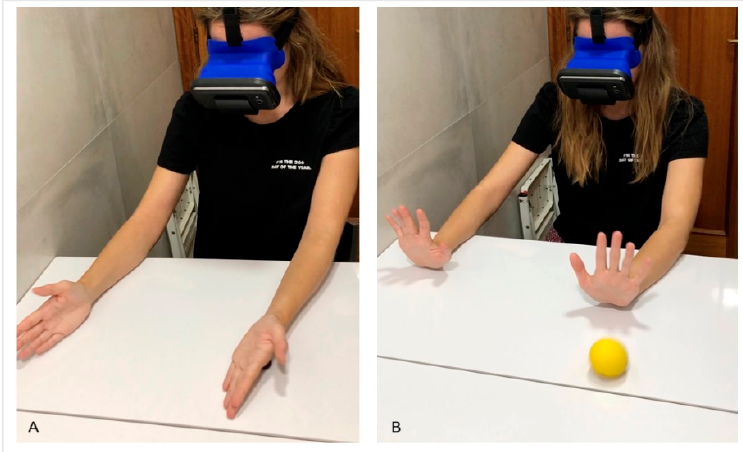
Figure 2. Virtual Reality MT. It is observed the use of virtual reality glasses instead of the mirror box. The child must maintain a straight head position with the glasses in midline, looking towards the hands. The child must execute the request movement with both hands at the same time. The affected hand will perform the activity according to its ability, trying to imitate the proposed movement. In the picture ( A ), it is executed the forearm supination to crush the plasticine balls with the back of the hands. In the picture ( B ), it is seen the wrist extension movement to throw the ball and try to stop it.